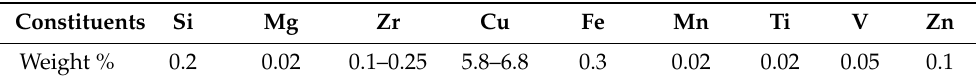
Table 1. Constituents of Al2219 [37].